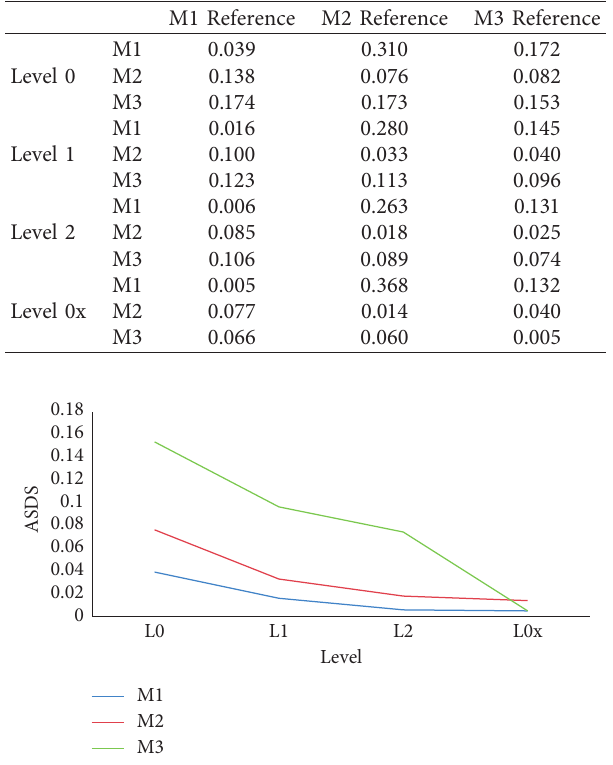
Figure 6: The minimum ASDS for each type in every level using an internal reference.